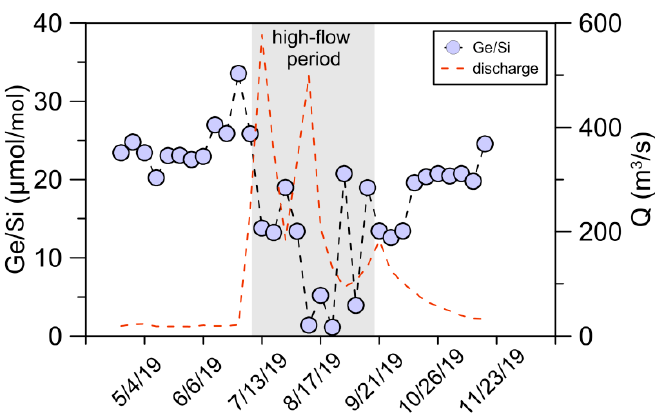
Figure 7. Ge/Si ratio variation in time series river water samples in Xiangqu.